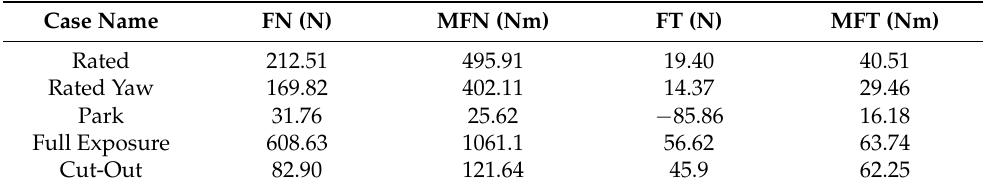
Figure 13. Blade force per unit length: ( a ) normal to the rotor plane (positive downwind) and ( b ) tangential to the rotor plane (positive in the blade rotation direction. Table 7. Blade – root loads for the design load cases. F N is the force normal to the rotor plane, F T the tangential force, M FN the out-of-plane bending moment and M FT the torque.